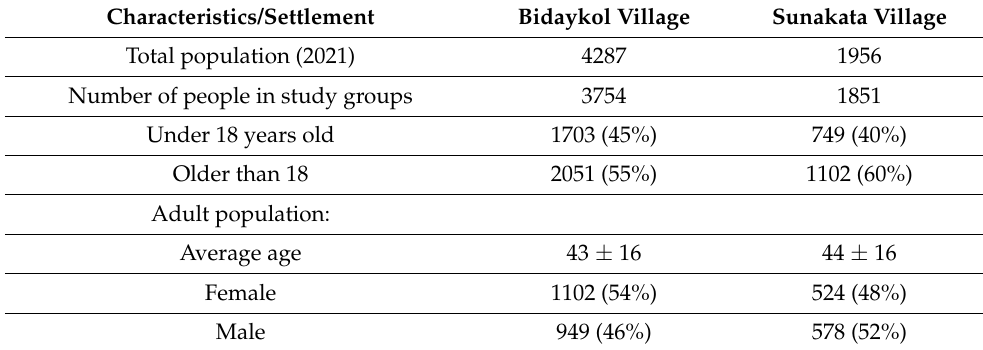
Table 1. Characteristics of the population of the main and control groups.